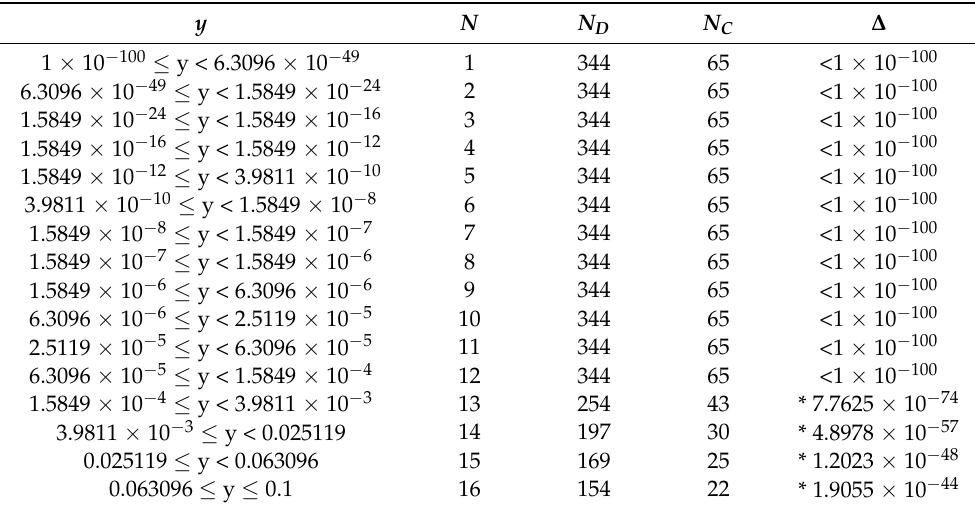
Table 2. The optimal parameters N , N D , and N C with accuracy levels ∆ = 1 × 10 − 100 . y N N D N C